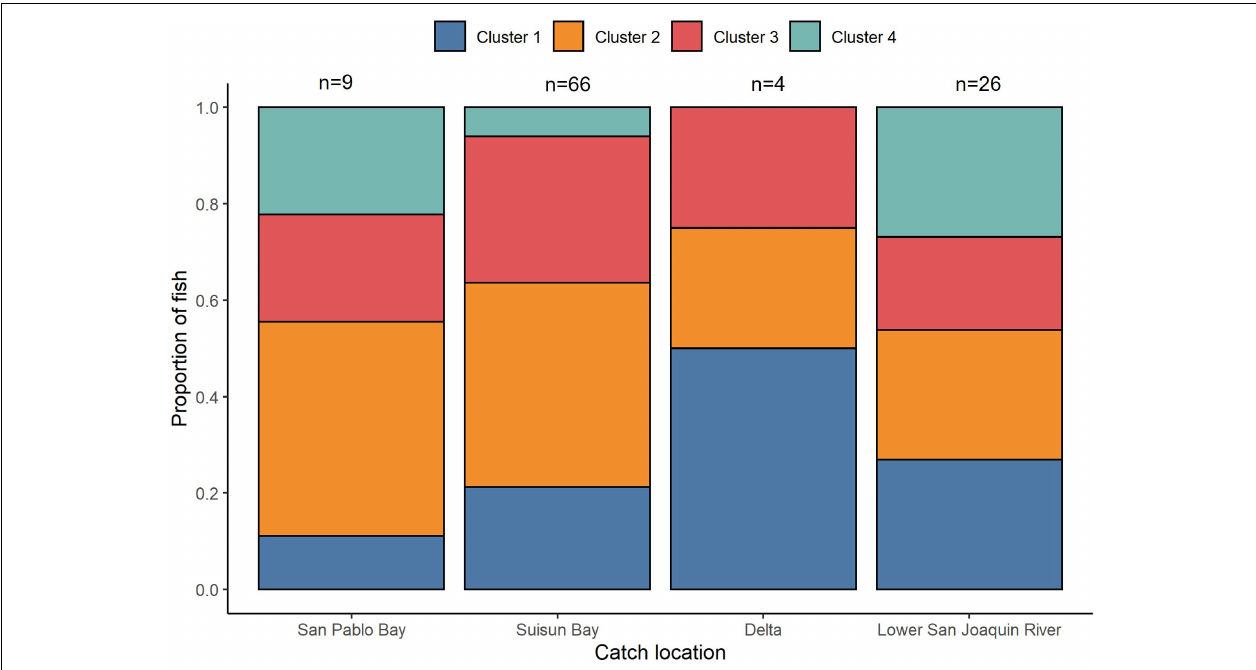
FIGURE 9 | Regional variation in migratory cluster composition of San Francisco Estuary White Sturgeon. The proportion of White Sturgeon belonging to each of the four sub-adult life-history clusters is shown for each region. Regions are defined in Figure 1 and clusters are defined in Figure 8